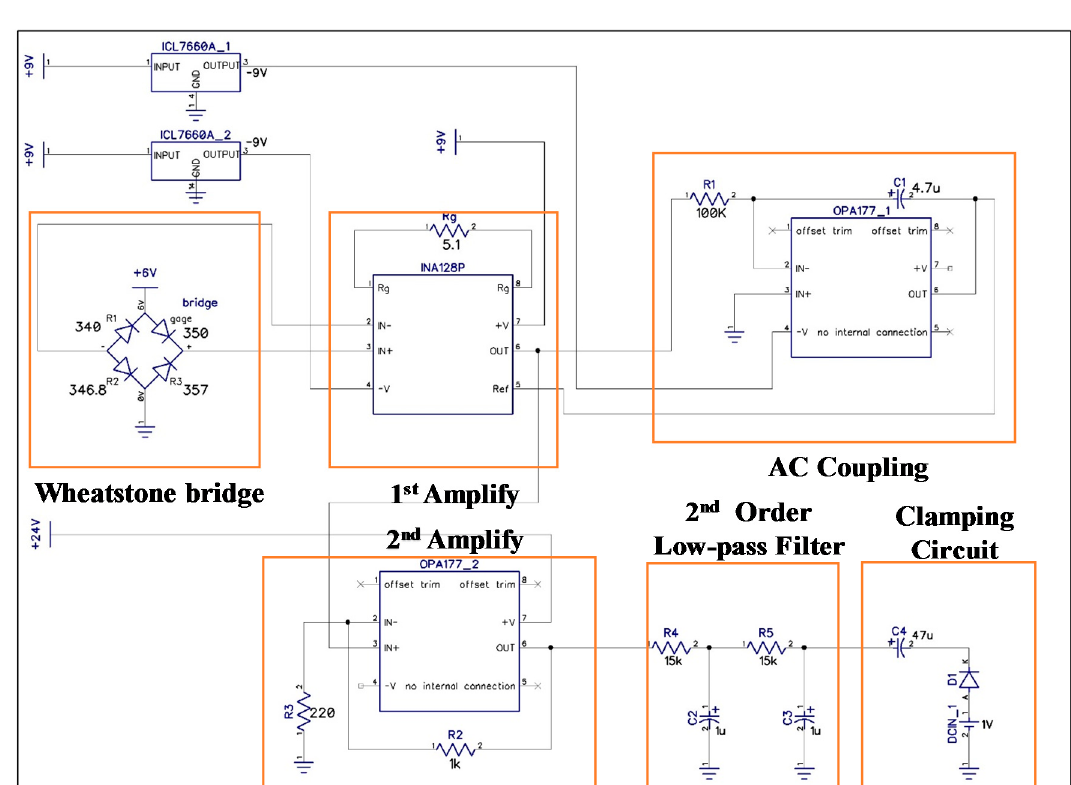
Schematic of the front-end circuit designed for the strain-based pulse wave sensor.